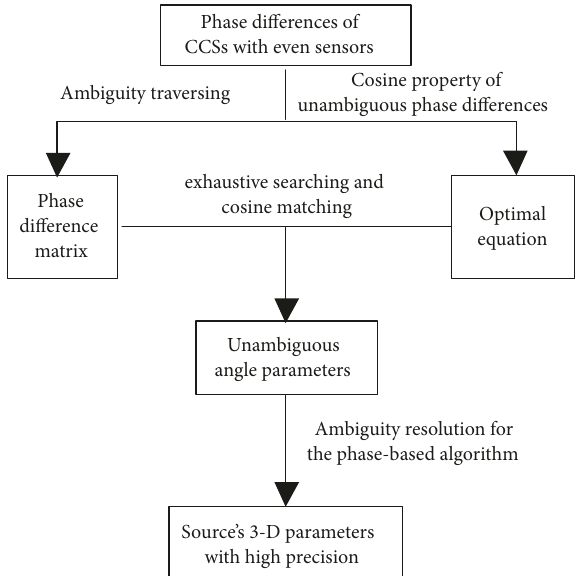
Figure 2: Flowchart of source’s unambiguous 3D localization.